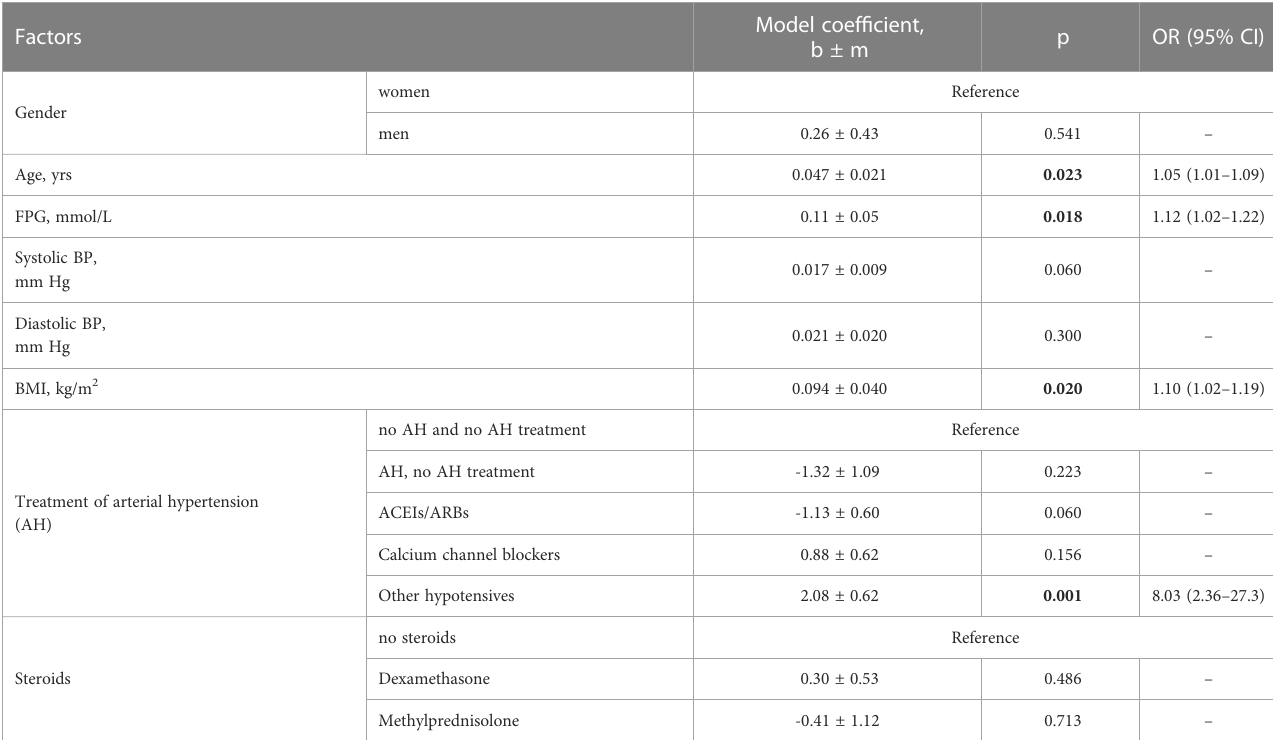
TABLE 5 Risks of death of COVID-19 inpatients with diabetes mellitus (n=150) estimated using one-way logistic regression models. Factors